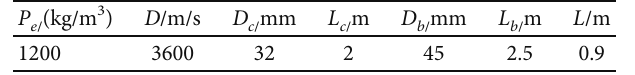
Table 1: Blasting parameters.